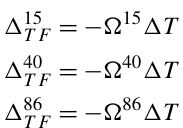
Figure A2. Argon isotopic enrichment due to gas loss in the Byrd core used to determine the δ 40 Ar gas loss correction (Ap- pendix A1). The enrichment in δ 40 Ar plotted as a function of gravitationally corrected ( δ O 2 / N 2 – δ Ar / N 2 ) measured in the deep Antarctic Byrd ice core, which suffered heavy gas loss. Ice samples were analyzed in the Bender Lab at the University of Rhode Island by Jeff Severinghaus in 1997. The slope of the least-square fit is ε 40 = − 0 . 008. The data point in parentheses is treated as an outlier and excluded from the